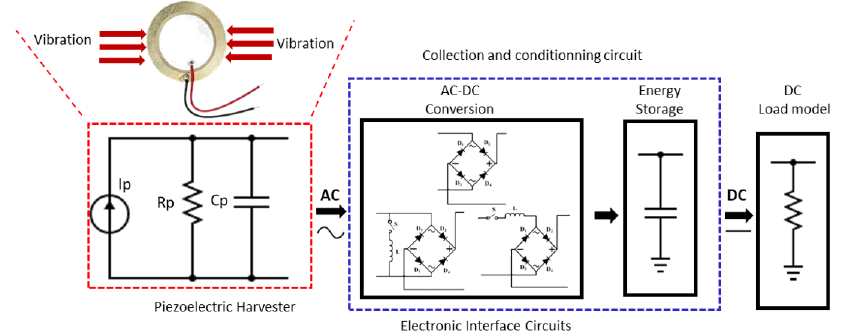
Figure 1. Block diagram of PEH